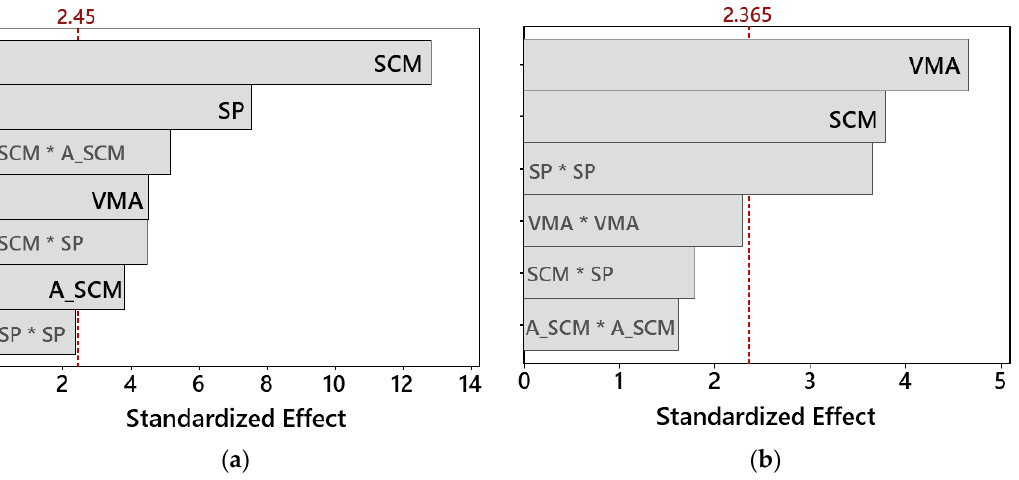
Figure 1. Pareto chart of the standardized effects for slump flow ( a ), and V-funnel time ( b ).